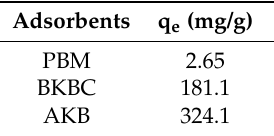
Table 3. Maximal adsorption capacity of MB on as-prepared samples.